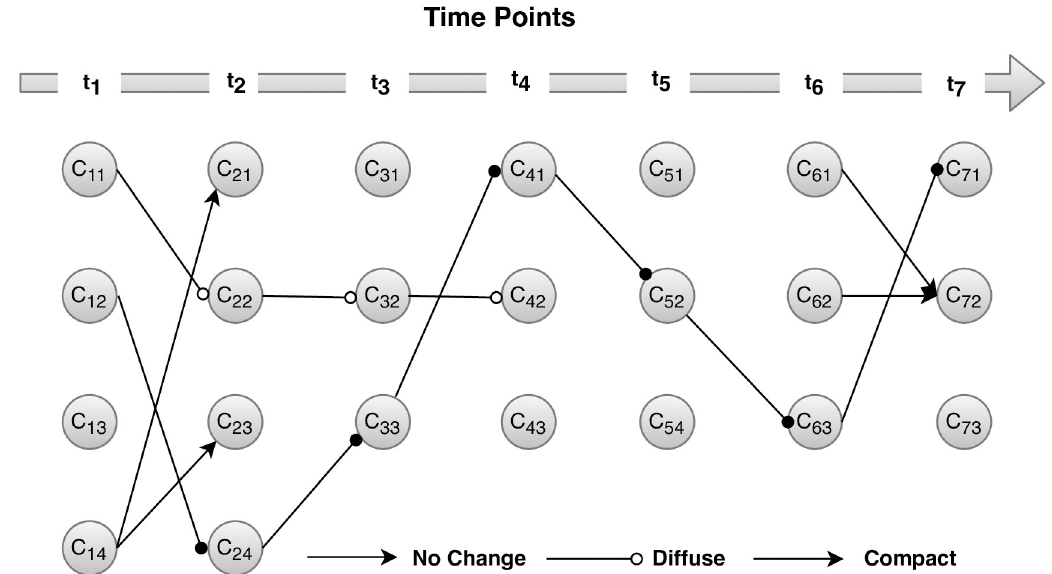
Fig 3. Cluster’s evolution over time. The nodes represents the clusters whereas the edges represents the transition experienced by respective clusters. The first subscript in C represents the time points, whereas the second subscript represents the cluster. ij